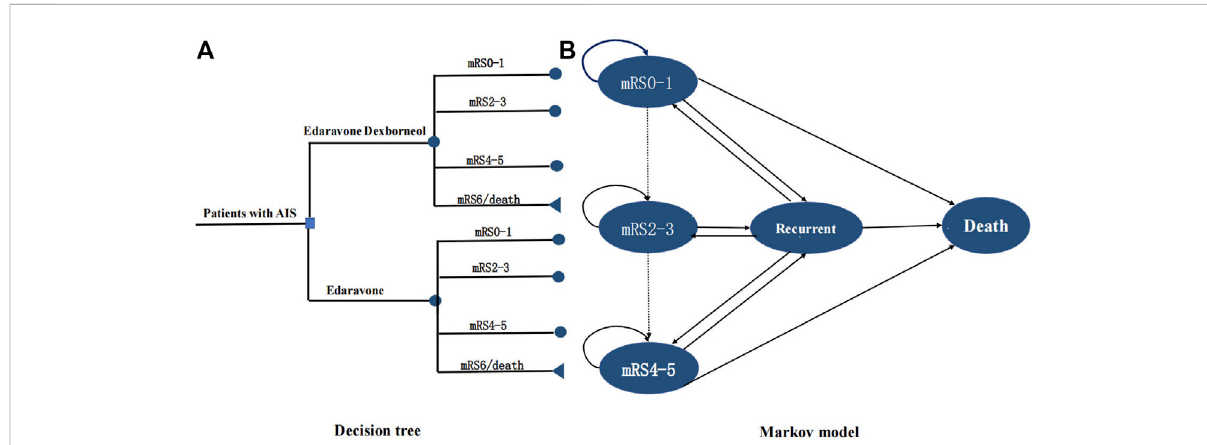
FIGURE 1 Modelstructure. (A) Short-termdecisiontreemodeland (B) .long-termMarkovstatetransitionmodel.Apatientwithanacuteischemicstrokewithin48 h aftersymptomonsetenteredthemodelat63 yoldreceivingeitheredaravonedexborneoloredaravone,andtransitionedbetweenhealthstatesuntildeathor 30 y.Patientsmayhaveastablehealthstate,transitiontoastateofequalorgreaterdisabilityafterrecurrentstroke,ordied.mRSindicatesmodi fi